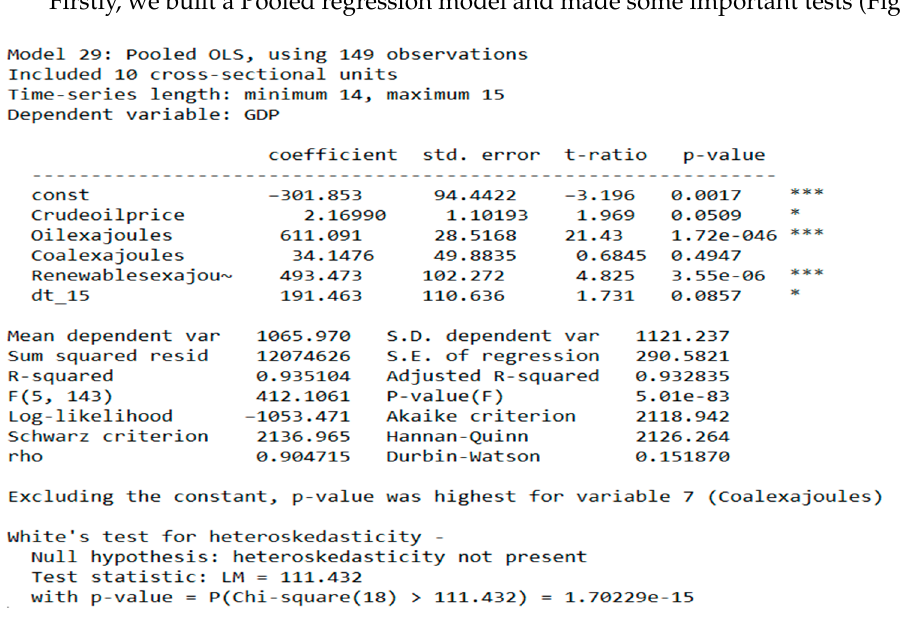
Figure 18. Pooled regression model. For 2006–2020 period. The adjusted R-squared was quite high, with low p -value of F, thus indicating that it was not formed due to random chance. The rho criterion was also close to 1, thus indicating a presence of significant individual